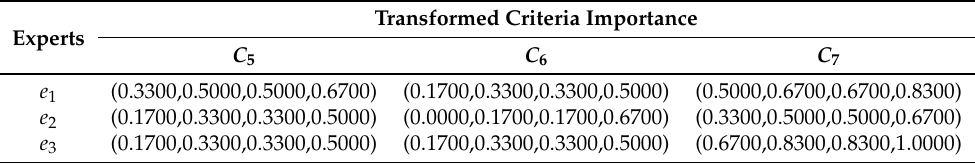
Table 9. Transformed information of fuzzy criteria weights ˜ W h -continued.